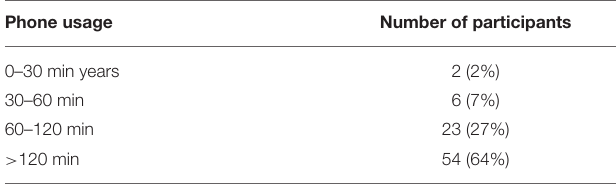
TABLE 2 | Self evaluation of the participants’ daily smartphone usage time ( n =